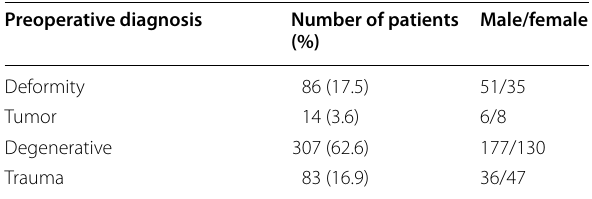
Table 1 Clinical characteristics and perioperative data Preoperative diagnosis